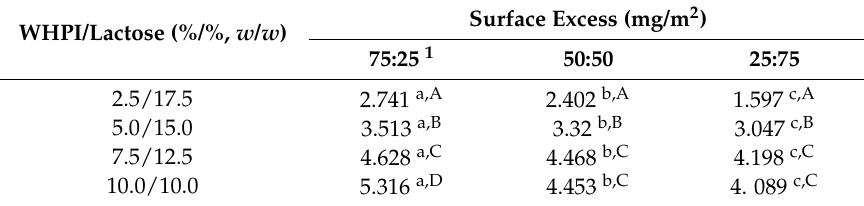
Table 2. The effect of wall composition and wall-to-core ratio on Surface Excess ( Γ ) of the investigated